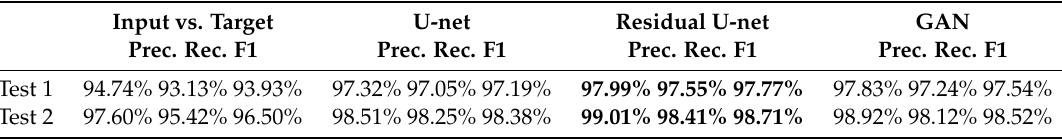
Table 4. Precision/recall/F1-score on the positive class for independent test sets at map scale